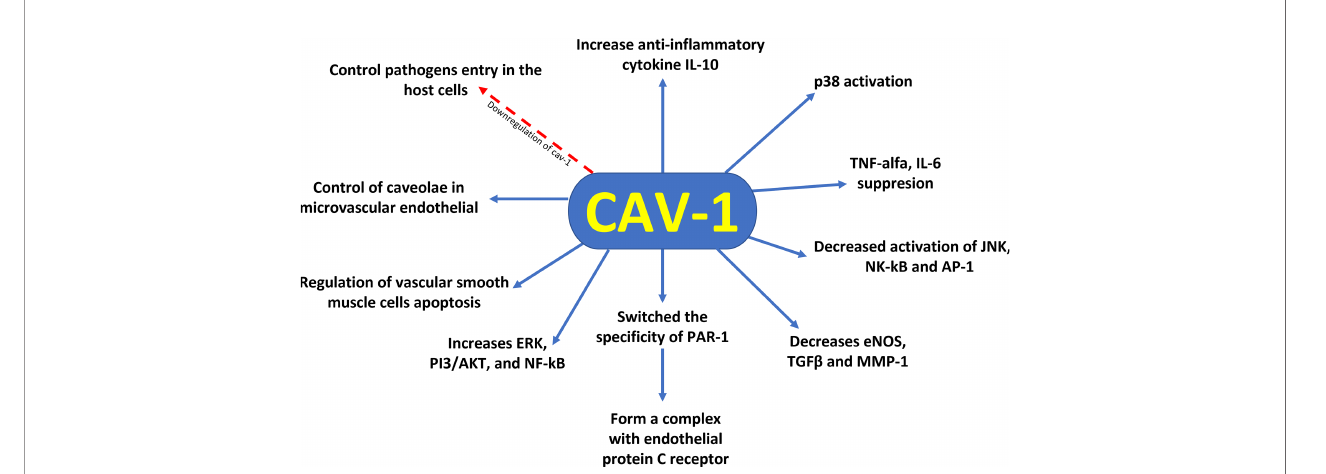
FIGURE 1 | Cytoprotective pro fi le of Cav – 1 against sepsis – induced mortality. Downregulation of caveolin – 1 decreases caveolae available to control pathogen entry into host cells, control of caveolae in the microvascular endothelia of the lung reveals regulation of vascular smooth muscle cells apoptosis, reduction of Cav – 1 switches the speci fi city of PAR – 1 to initiate protective response in endothelial cells by altering the occupancy of endothelial protein C receptor. In addition, Cav – 1 has a protective role for in fl ammation by suppression of proin fl ammatory cytokines (TNF – a and IL – 6) production, augmentation of antiin fl ammatory IL – 10 cytokine production, and involvement of the p38 MAPK, JNK, NK – k B, and AP – 1 signal